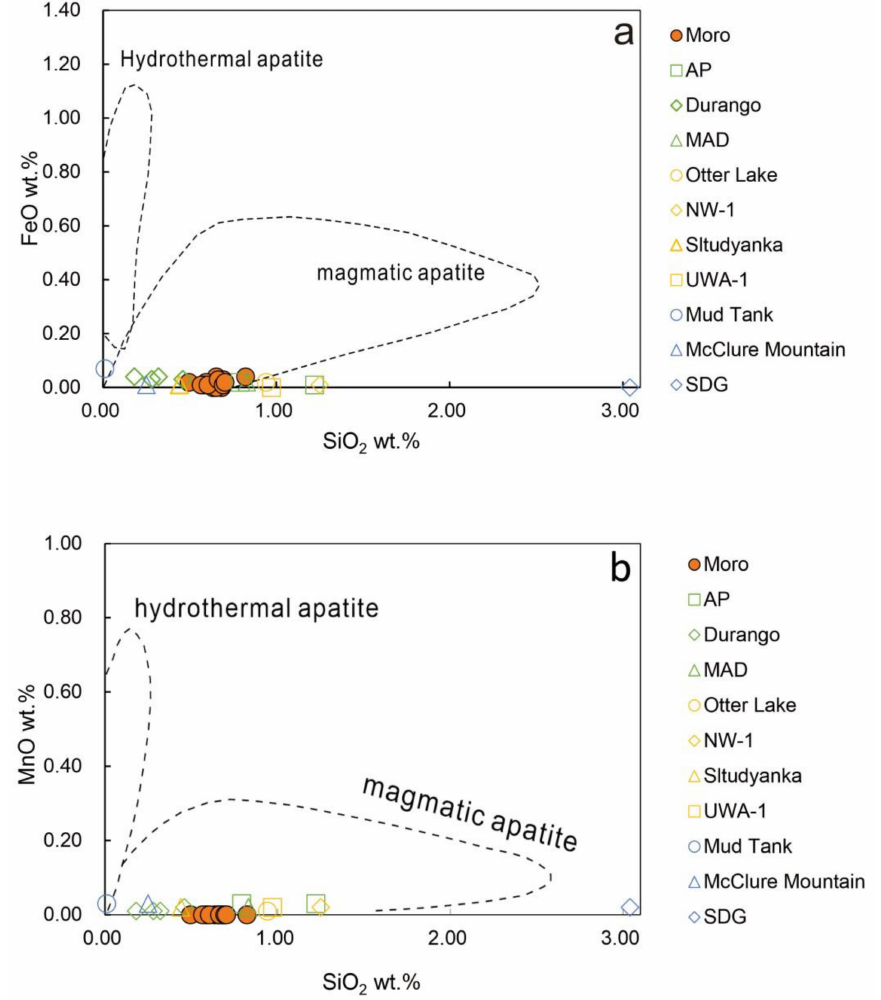
Figure 7. Illustration of the origin of the Moroccan apatites and the apatites mentioned by Yang [41]: